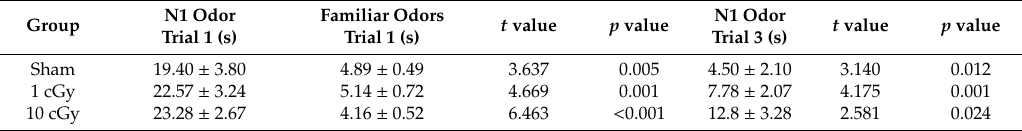
Figure 3. Mean total seconds of exploration on Trials 1 and 3 for Habituation and the Recognition Test at one month (top panels; n = 12–16) and six months (bottom panels; n = 10–13) following exposure. No differences were found among the groups during Habituation at either time point. At